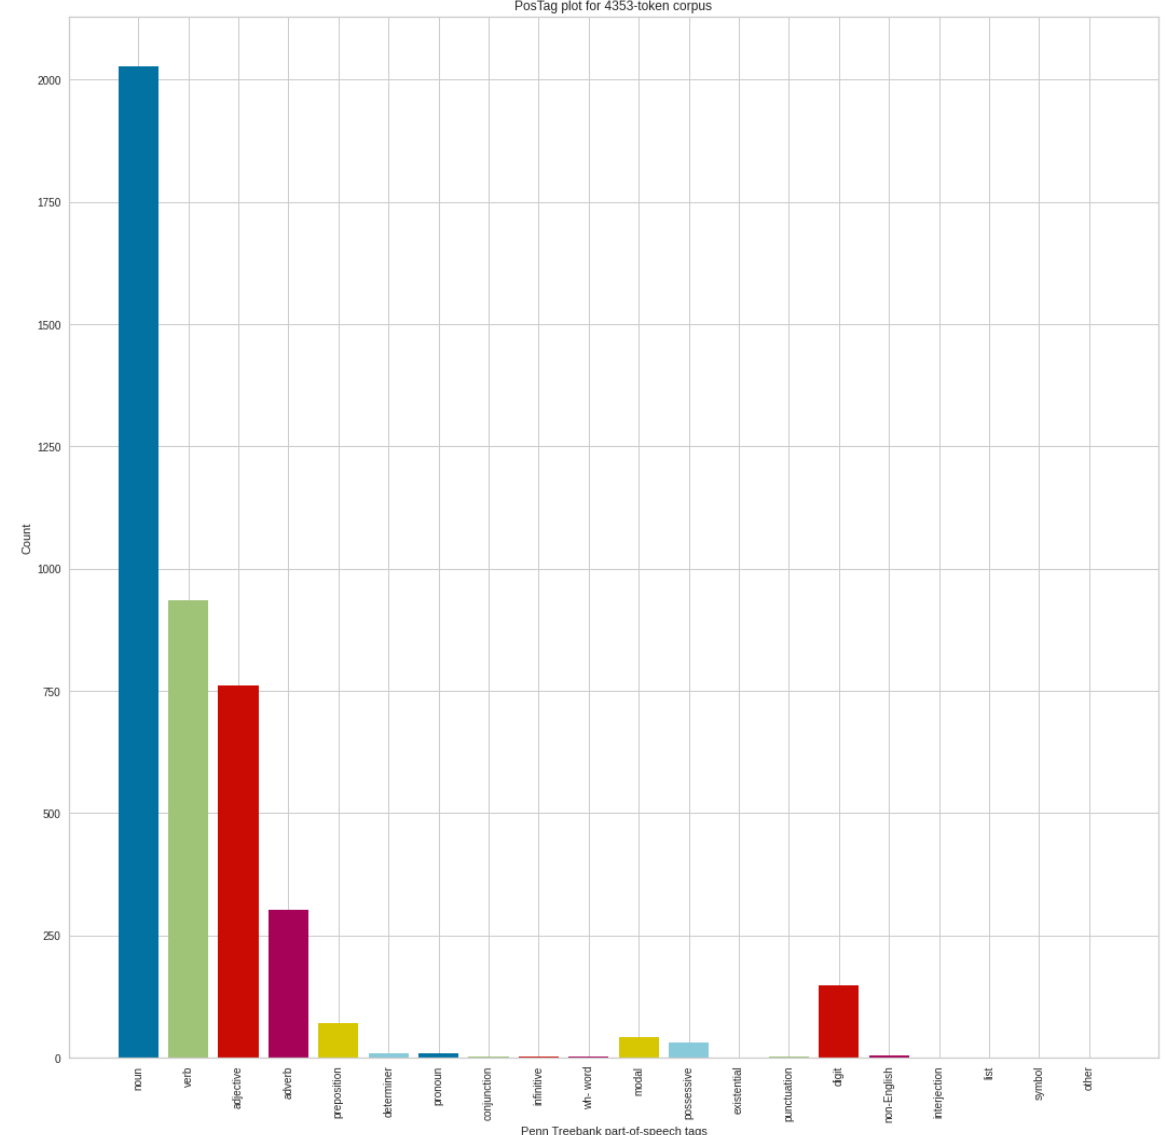
Figure 13. Part of speech tagging for negative tweets. The time periods stands between 2 September 2021 and 4 Septem- ber